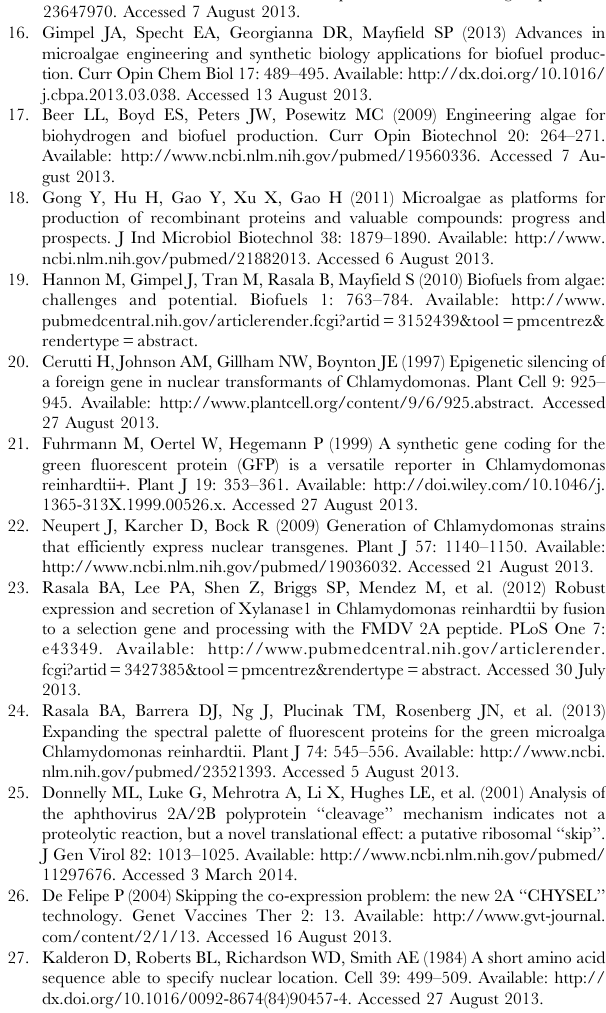
Figure S4 Transgenes expressed from the nuclear genome of C.